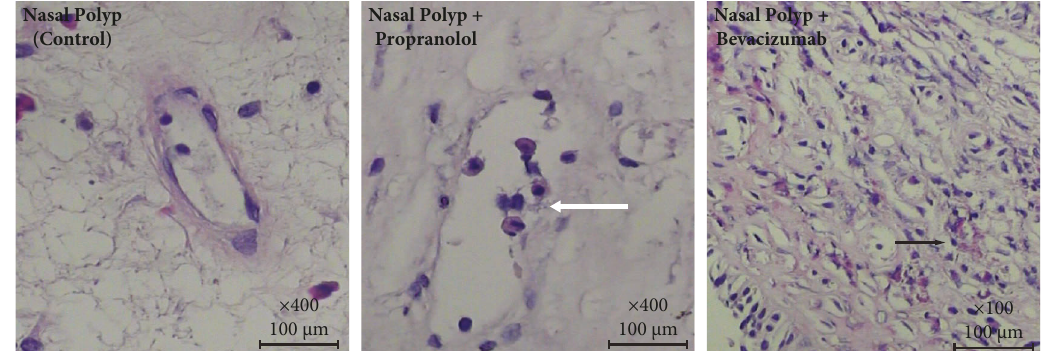
Figure 4: Light microscopic findings on nasal polyps groups showing endotel cell damage (thick White arrow) in Propronalol group; hyalen necrosis in Bevacizumab group (thick black arrow). (Hematoxylin-eosin stained 5 micrometer thin slides: nasal polyp control and propranolol × 400; bevacizumab ×